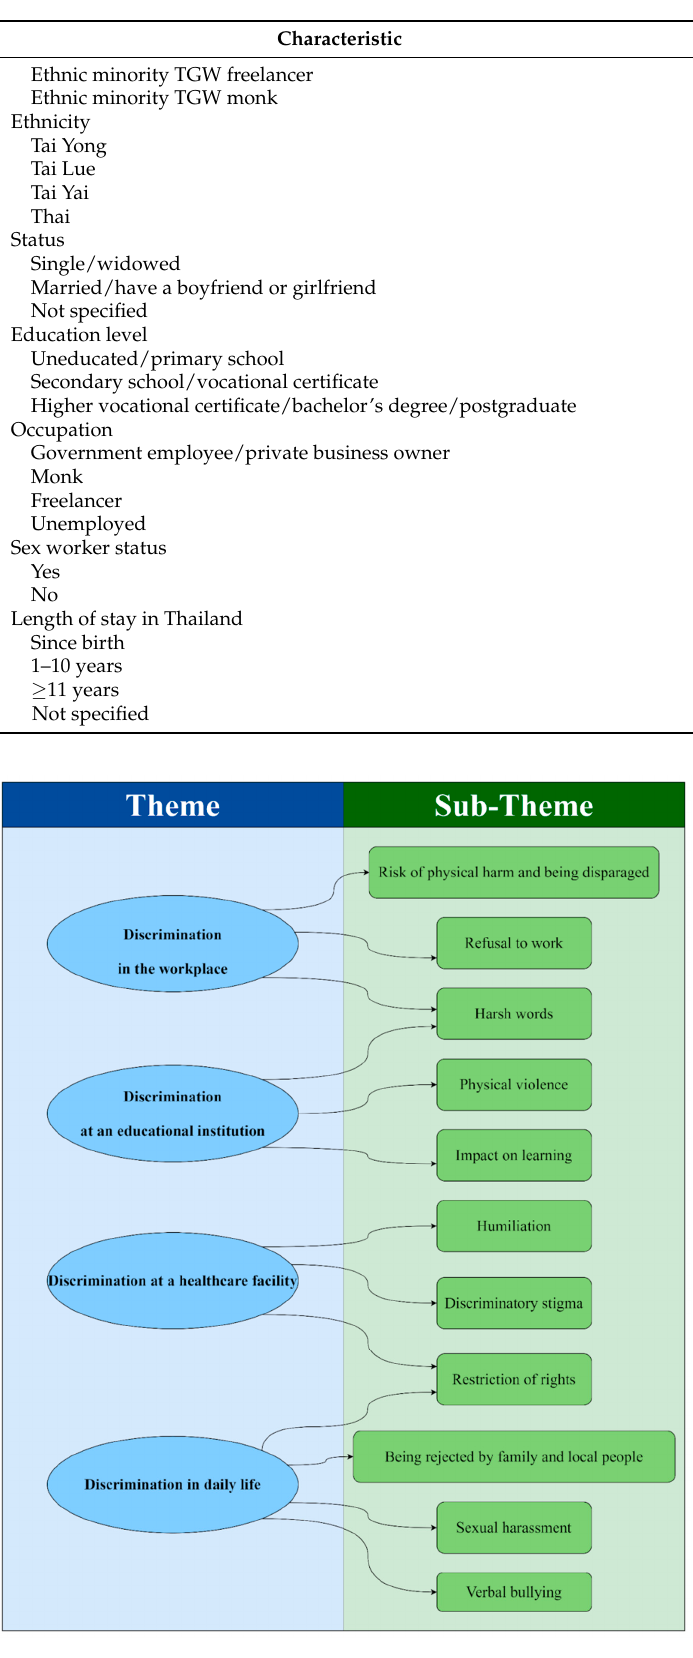
Figure 2. Themes and sub-themes used in the study.